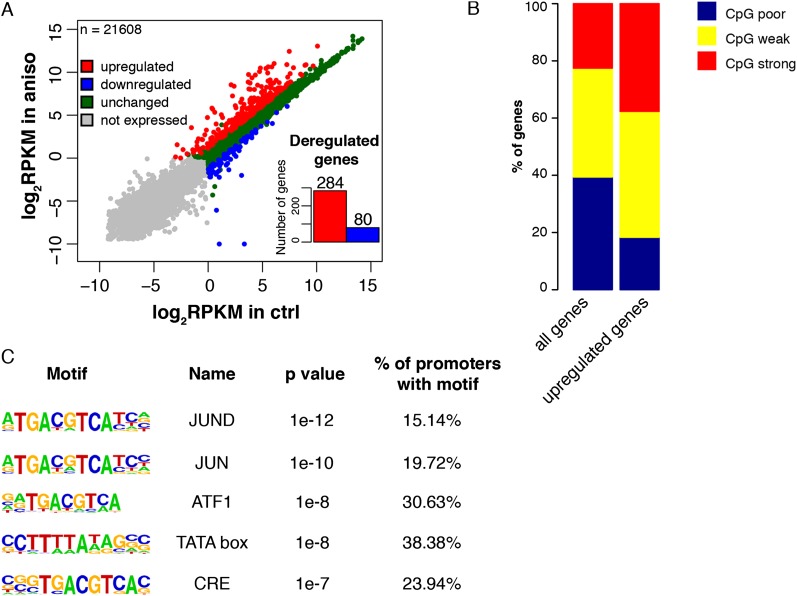
Stress signaling via p38/MAPK mainly targets the regulators of signal transduction characterized by the high CG content of their promoters. (A) Changes in mRNA abundance of 21,608 RefSeq genes upon stress stimulation determined by full-length mRNA-seq. (B) Histogram showing the distribution of promoter classes according to CpG content. Weak and strong CpG promoters are enriched in the group of up-regulated genes (P-value = 1.052 × 10−14, χ2 test). (C) Transcription-factor motifs enriched in promoter regions (located between 400 bp upstream of and 100 bp downstream from the TSS) of up-regulated genes.